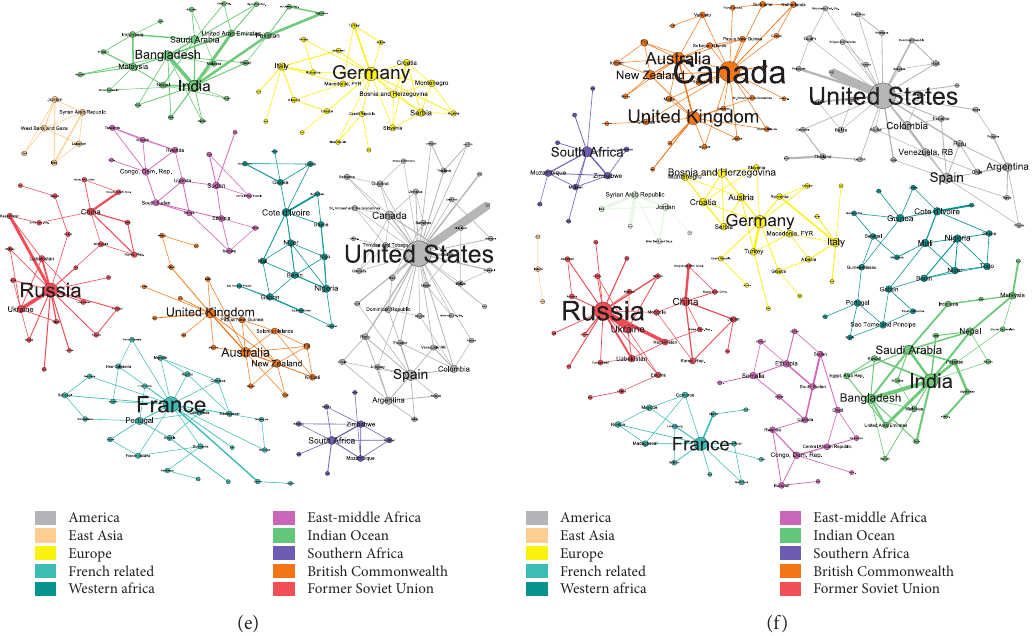
Figure 8: Communities and structural evolution of GMNs from 1960 to 2015. (a) 1960–1969. (b) 1970–1979. (c) 1980–1989. (d) 1990–1999.